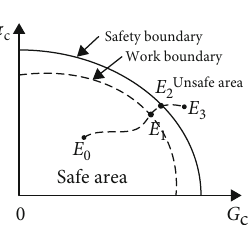
Figure 8: Determining the boundaries of the failure modes.